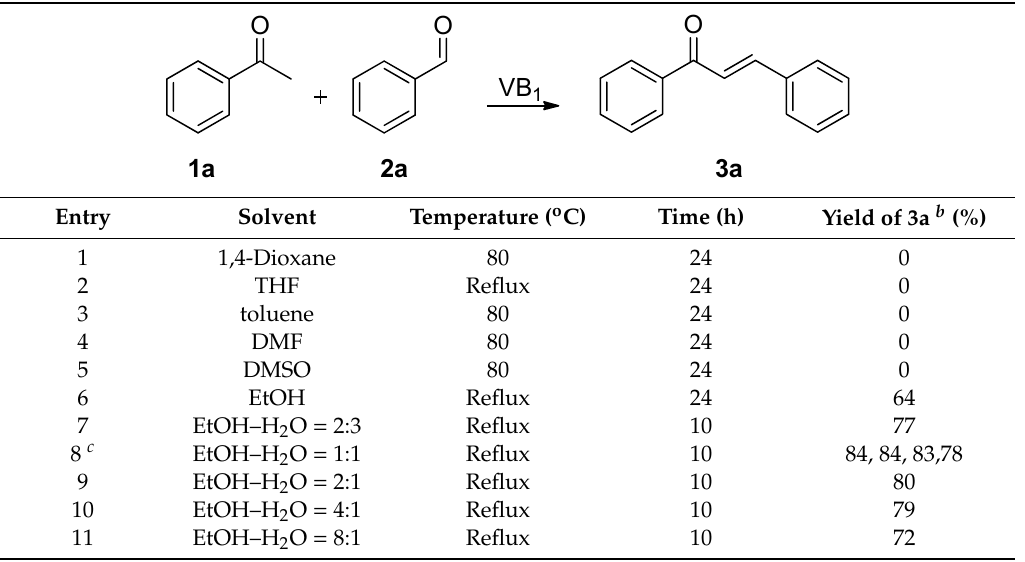
Table 1. The optimization of the reaction conditions a.